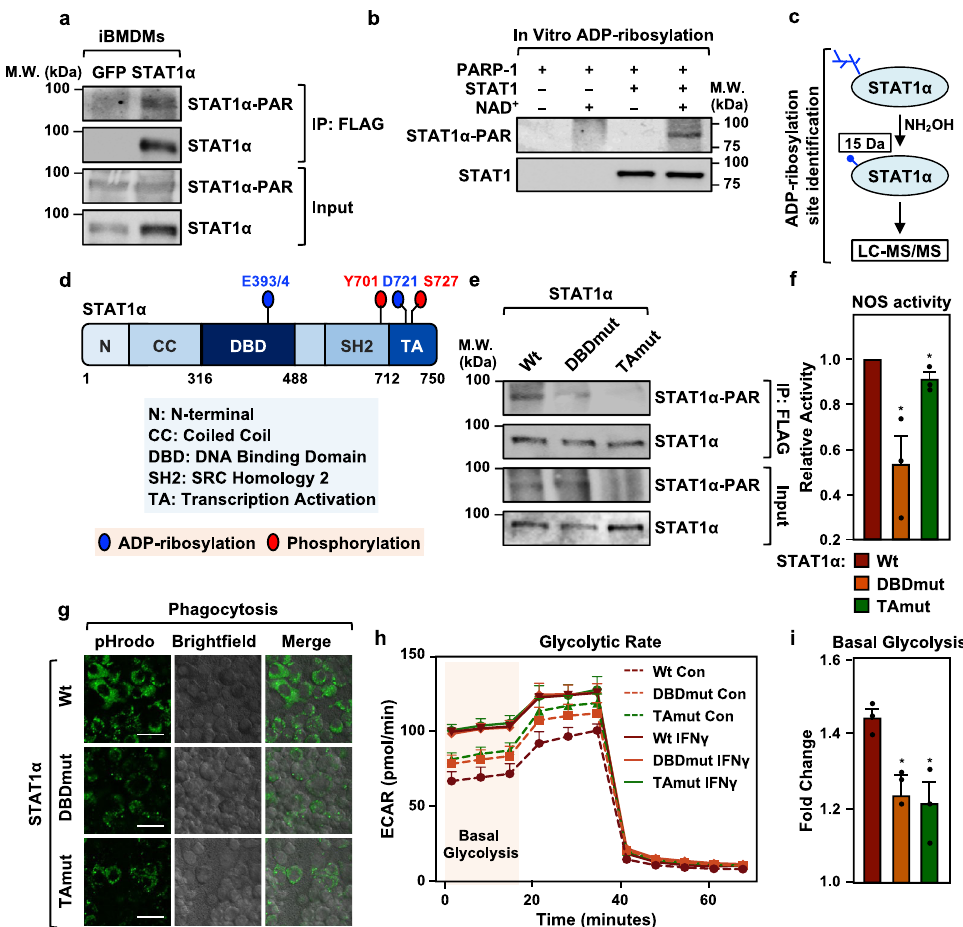
Fig. 4 ADPRylation of STAT1 α by PARP-1 at speci fi c sites on the DNA-binding and transactivation domains is required for facilitating pro- in fl ammatory responses in macrophages. a STAT1 α is ADPRylated in cells. Immunoblots showing ADPRylation of STAT1 α in immortalized